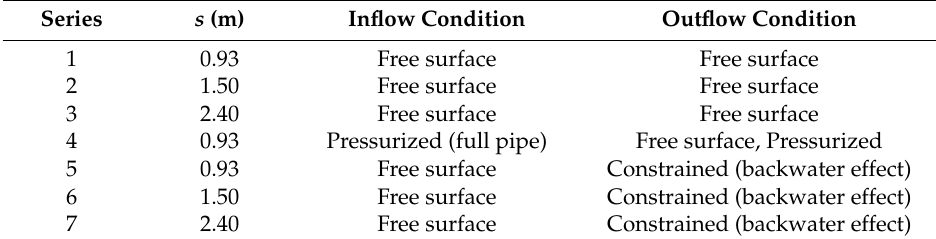
Table 1. List of experiments.